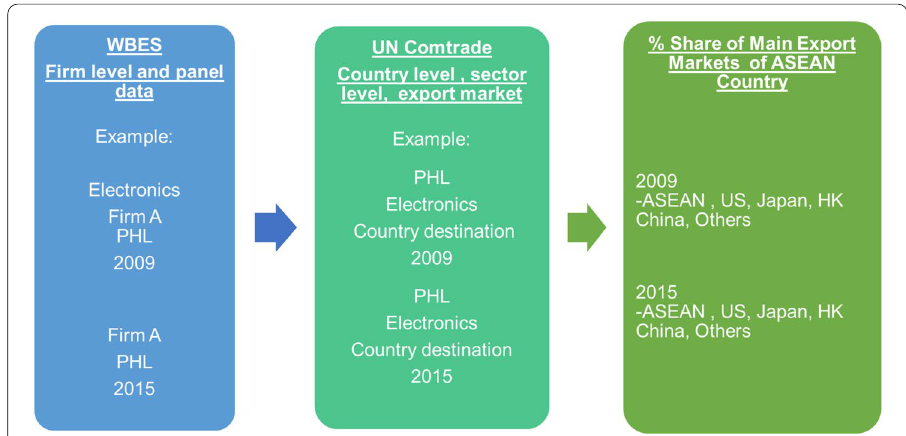
Fig. 2 Data construction of % export market share (source: